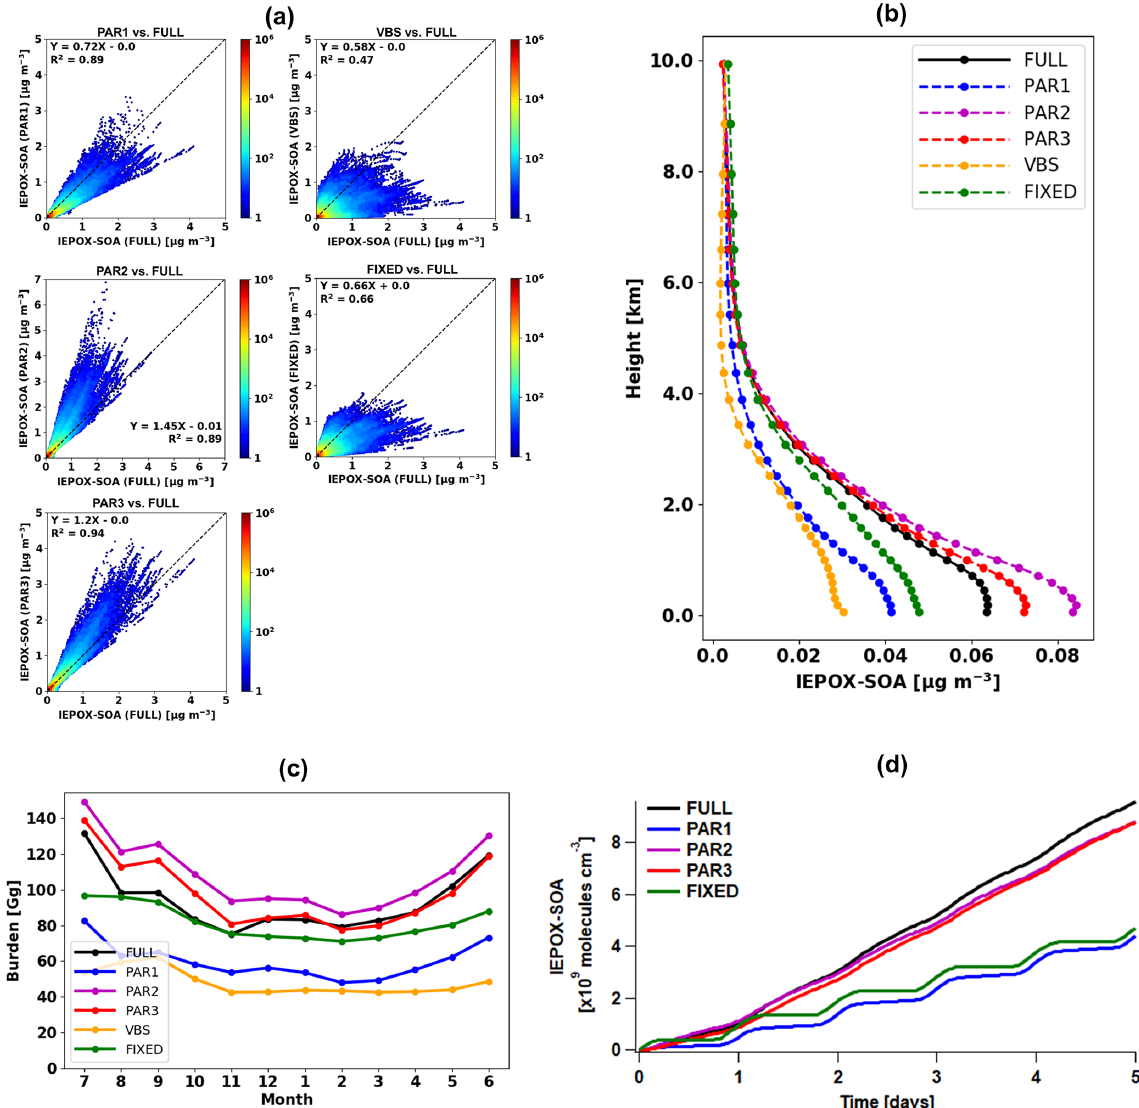
Figure 4. (a) Scatterplots of parameterized ( y axis) versus full chemistry IEPOX-SOA ( x axis) concentrations within the troposphere for July 2013–June 2014. Each point represents monthly averaged model grid value of IEPOX-SOA concentration. Colors represent the density of points, where densities were calculated by dividing x - and y -axis ranges into 100 by 100 grid cells. (b) Vertical profiles of global annual mean average IEPOX-SOA concentrations. The vertical locations of the markers indicate the midlevels of the vertical grid boxes in GEOS- Chem. (c) Time series of global tropospheric burdens of IEPOX-SOA (Gg). (d) Time series of IEPOX-SOA concentrations simulated by the box model. The VBS was not calculated with the box model, as it requires additional partitioning calculation with preexisting aerosols, which are calculated online in GEOS-Chem. Input chemical/meteorological fields were averaged from GEOS-Chem results for four major isoprene source regions (the southeastern United States: 30–40 ◦ N, 100–80 ◦ W; the Amazon: 10–0 ◦ S, 70–60 ◦ W; Central Africa: 5–15 ◦ N, 10–30 ◦ E; Borneo: 5 ◦ S–5 ◦ N, 105–120 ◦ E). Input values represent annual mean values, which were calculated by using the first 2d of each month model outputs at 30min interval averaged within the